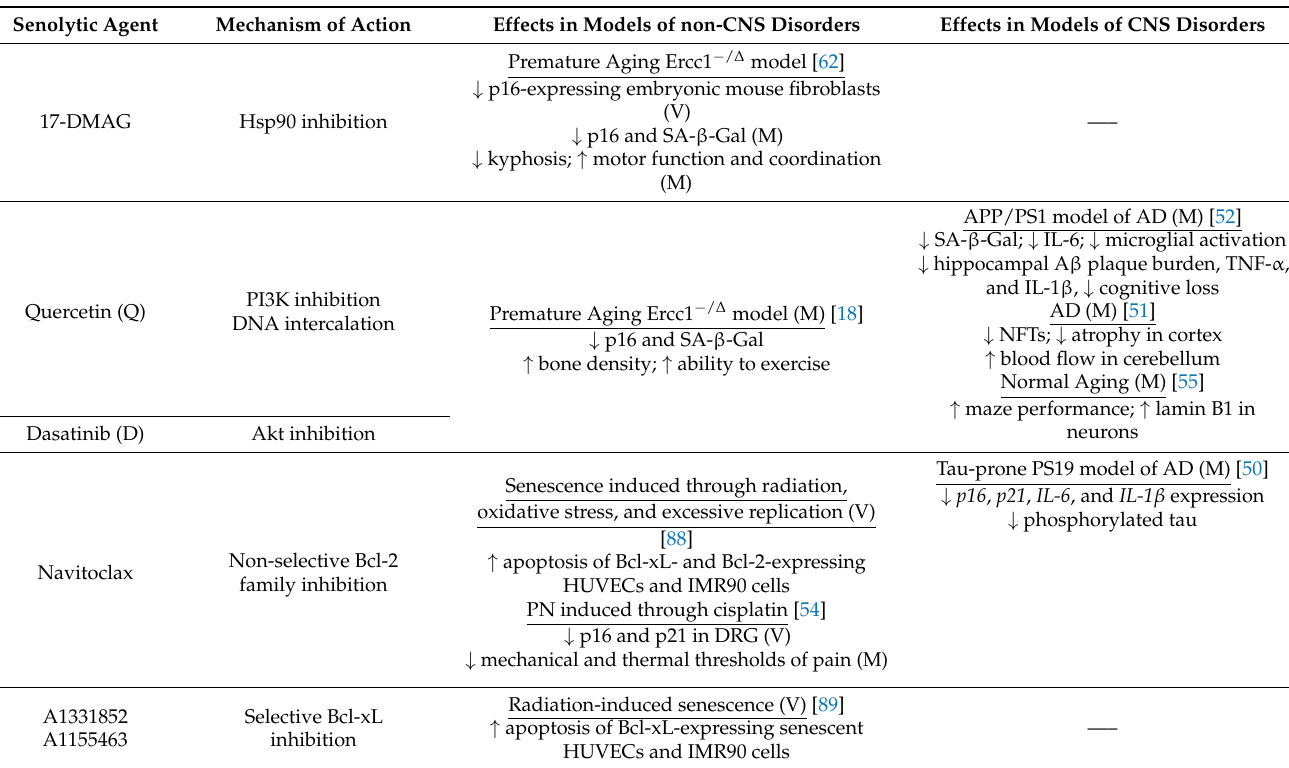
Table 1. A selection of current senolytic agents. M: mouse; V: in vitro; Ercc1 − / ∆ : ERCC Excision Repair 1-deficient; AD: Alzheimer (cid:48) s Disease; NFTs: neurofibrillary tangles; HUVECs: human umbilical vein endothelial cells; IMR90: human lung fibroblast cells; PN: peripheral neuropathy; DRG: dorsal root ganglia; ↑ denotes increase/improvement; ↓ denotes